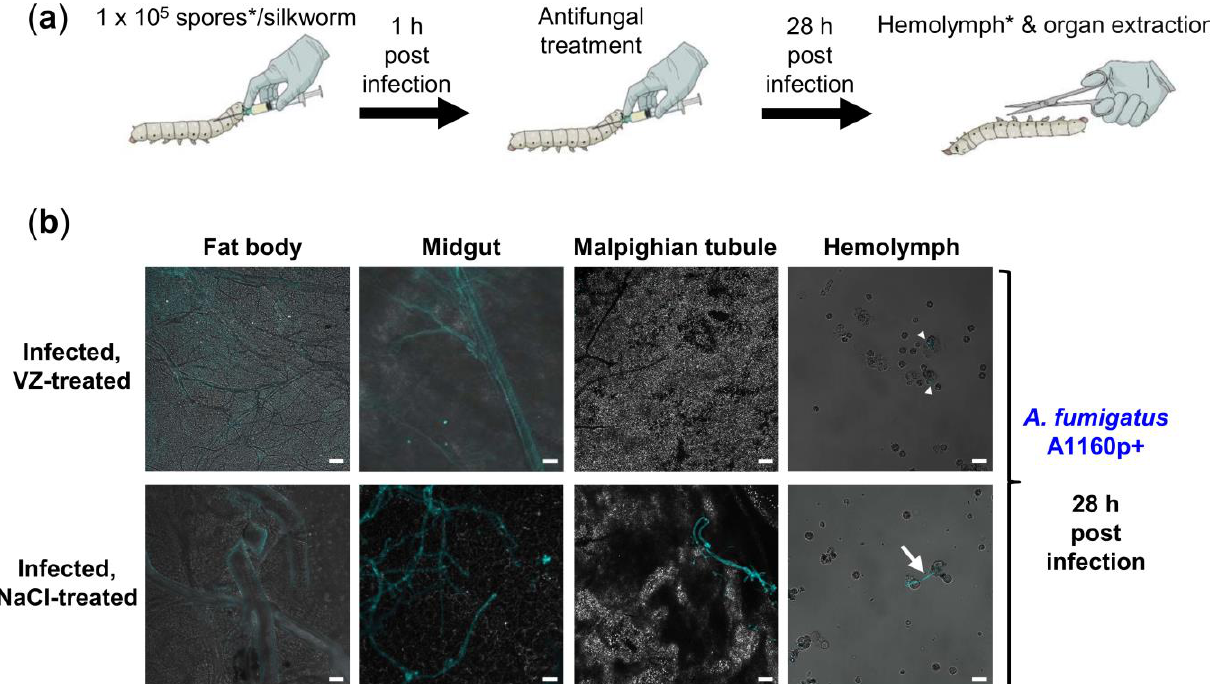
Figure 3. Therapeutic efficacy and safety of voriconazole in A. fumigatus -infected silkworms. ( a ) Illustration of experimental setup; treatment of A. fumigatus -infected silkworms with voriconazole at doses of either 1, 3.2 or 10 µg/day, respectively, resulted in 100% survival in all treatment groups in comparison to 0% survival of the infected, NaCl-treated controls; * for visualization of the fungus in the hemolymph, calcofluor white pre-stained spores were used for infection; ( b ) merged images (calcofluor white in turquoise + brightfield) show fungal burden in silkworms infected with the A. fumigatus A1160p+ strain at 28 h post infection, with or without the voriconazole (VZ) treatment (10 µg/silkworm at 1 h post infection); infected, NaCl-treated control received 20 µL 0.9% NaCl/10% DMSO at the same time point; white arrow heads and white arrow indicate spores and long hypha in the hemolymph, respectively; scale bars represent 20 µm.